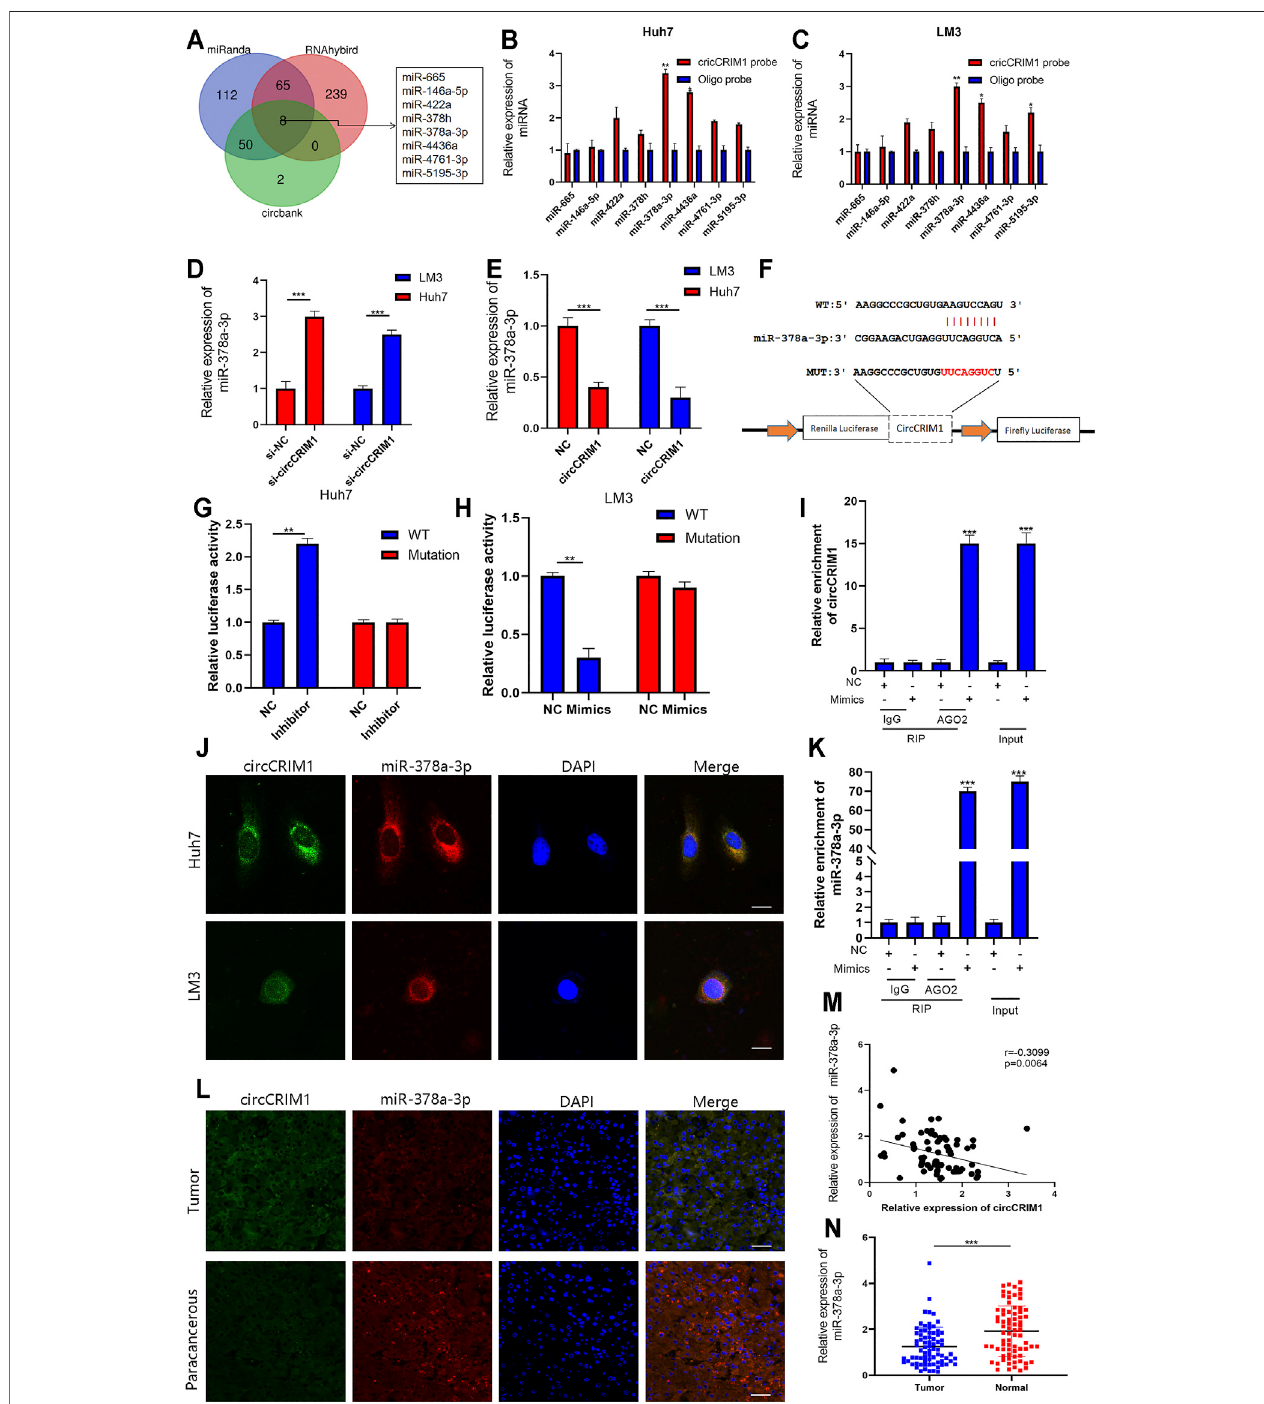
FIGURE 4 | CircCRIM1 functions as miR-378a-3p sponge in HCC (A) Venn diagram showing the overlap of target miRNAs for circCRIM1 predicted by miRanda, circbank, and RNAhybrid. (B,C) Relative abundance of eight miRNA candidates in Huh7 and LM3 lysates with circCRIM1 or oligo probe was examined by qRT-PCR. (D,E) Relative levels of miR-378a-3p in Huh7 and LM3 cell lines transfected with si-circCRIM1, si-NC, circCRIM1, or NC were detected by qRT-PCR (F) Schematic of wild-type(WT)andmutant(MUT)circCRIM1luciferasereportervectors (G,H) EffectsofmiR-378a-3pmimics,inhibitor,andNConluciferaseactivityweredetected inHCCcellstransfectedwithluciferasereportervectorsexpressingWT,MUT,orNC. (I,J) RIPassayforcircCRIM1wasperformedwithanti-AGO2antibodyinHCCcells transfected with mimics or NC, and expression of circCRIM1 and miR-378a-3p was detected by qRT-PCR. (K) Co-localization of circCRIM1 and miR-378a-3p in HCC cells was detected using a FISH assay. Scale bar,10 μ m (L) FISH results showing co-localization of circCRIM1 and miR-378a-3p in HCC and para-cancerous tissues frompatients.Scalebar,25 μ m (M) ObviouslynegativecorrelationbetweenlevelsofcircCRIM1andmiR-378a-3pin76pairsoffreshly-frozenHCCtissuesandmatched normal liver tissues was analyzed by Pearson correlation analysis. (N) Relative miR-378a-3p expression in 76 pairs of freshly-frozen HCC tissues and matched normal liver tissues. All data are presented as the means ± SD of three independent experiments. * p < 0.05, ** p < 0.01, and *** p < 0.001.